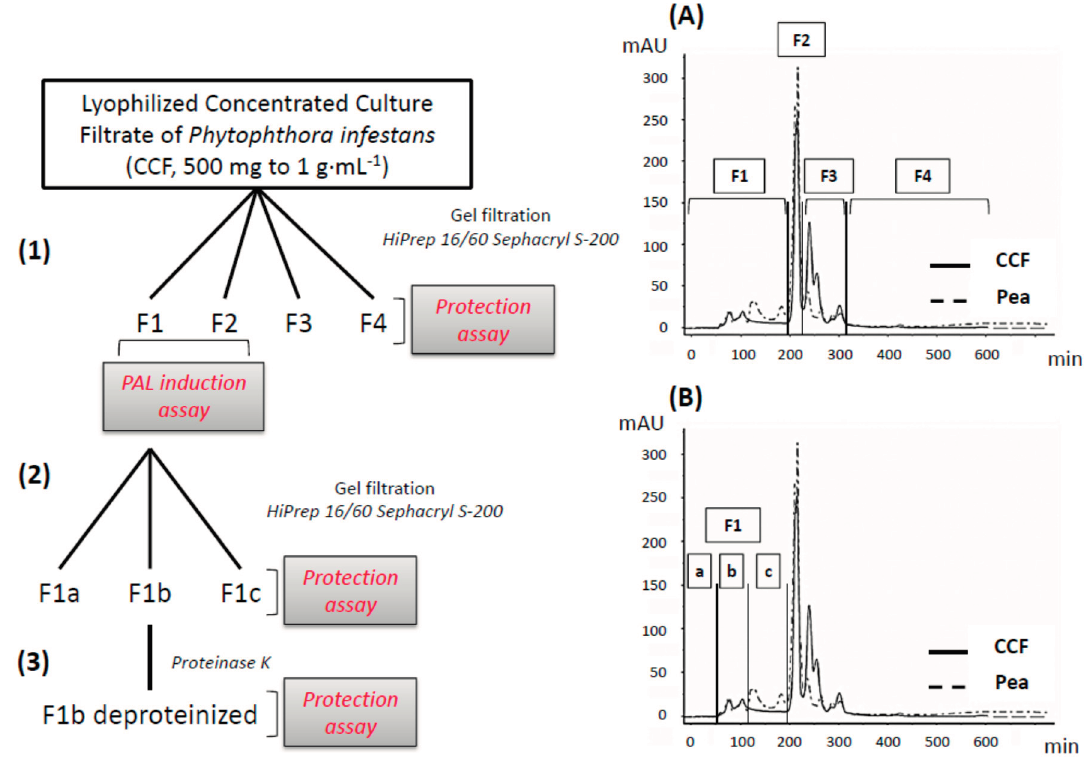
Figure 1. ( 1 ) The CCF is fractionated by gel filtration into four fractions (chromatogram ( A ) F1, F2, F3, and F4) and the induction of PAL activity is evaluated on F1 and F2 fractions. ( 2 ) The active fraction (F1) is separated by gel filtration into three subfractions (chromatogram ( B ) F1a, F1b and F1c). ( 3 ) F1b fraction was then deproteinized by the proteinase K. Each fraction (400 µg/slice) was tested on potato tubers for their protection effect against P. atrosepticum .